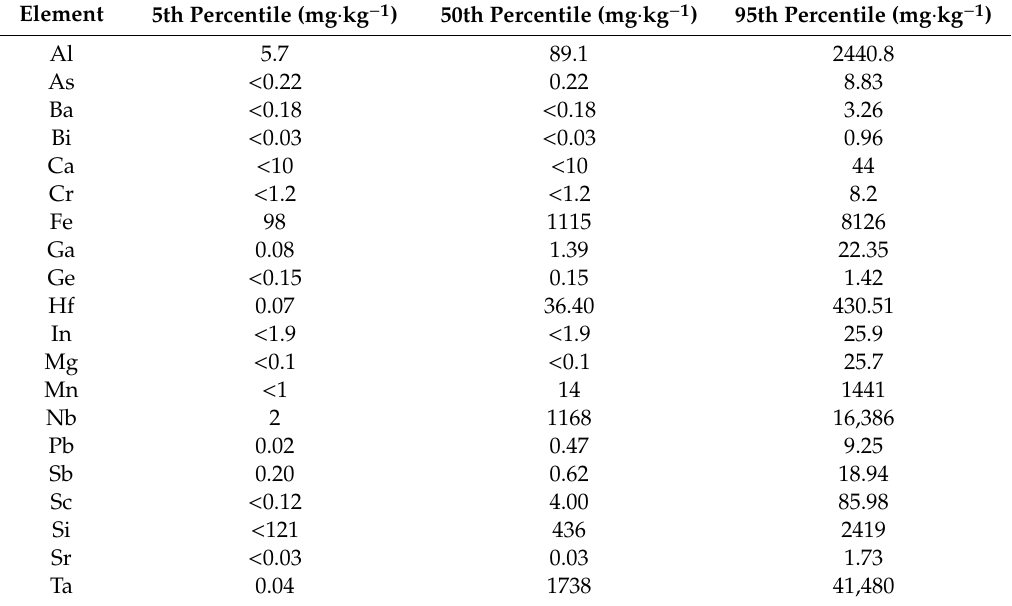
Table 1. Summary statistics of element concentrations in cassiterite